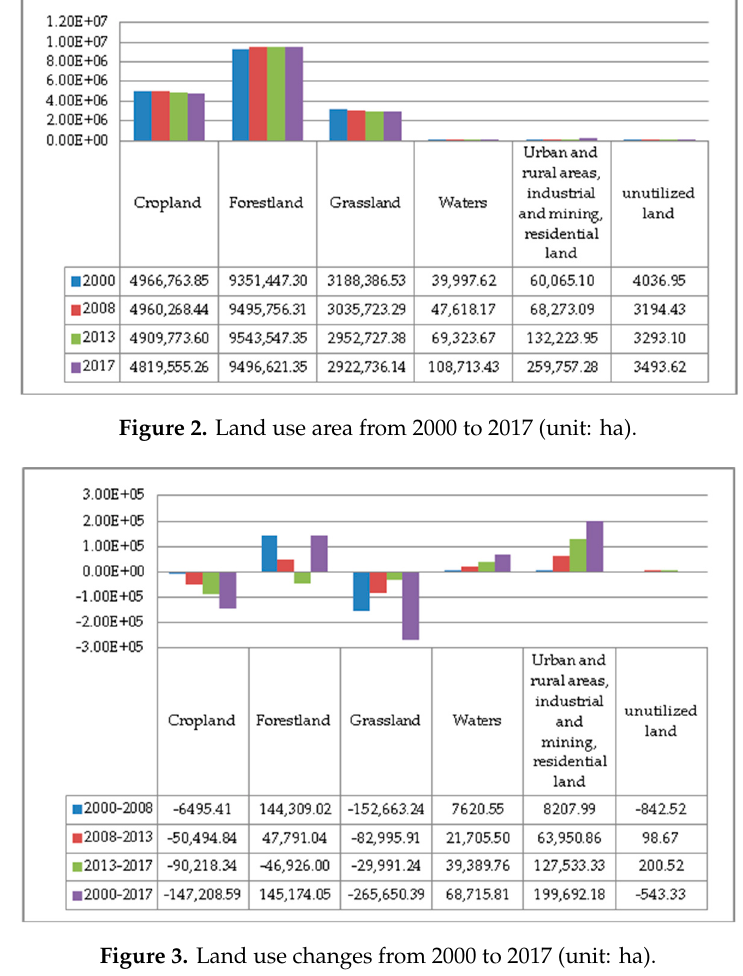
Figure 3. Land use changes from 2000 to 2017 (unit: ha).